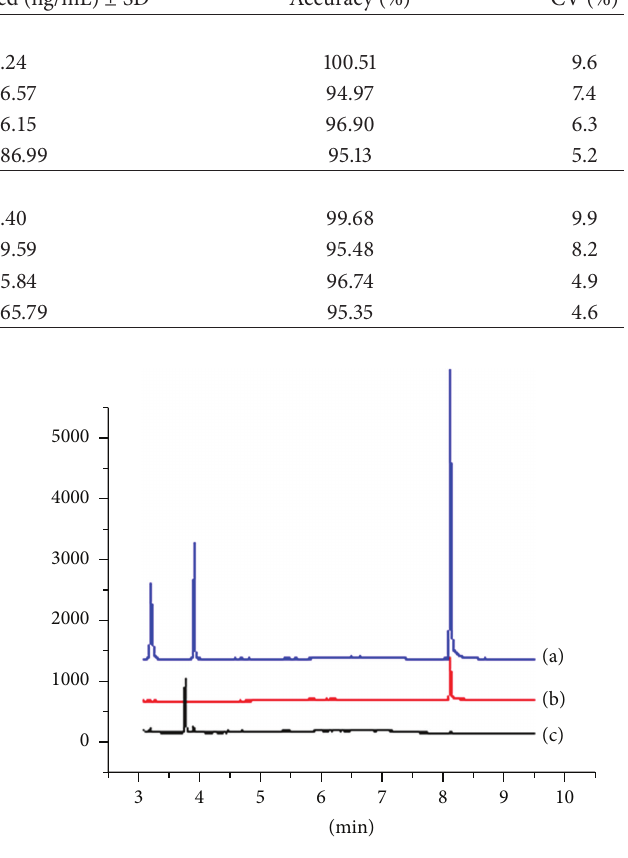
Figure 1: Chromatographic evaluation of the specificity of the method for detection of muscone in rat plasma. (a) Rat plasma sample obtained 3 h after oral administration of artificial musk (625 mg ⋅ kg −1 ), with internal standard added; (b) plasma sample from a control rat with muscone (378 ng ⋅ mL −1 ) added; (c) plasma sample from a control